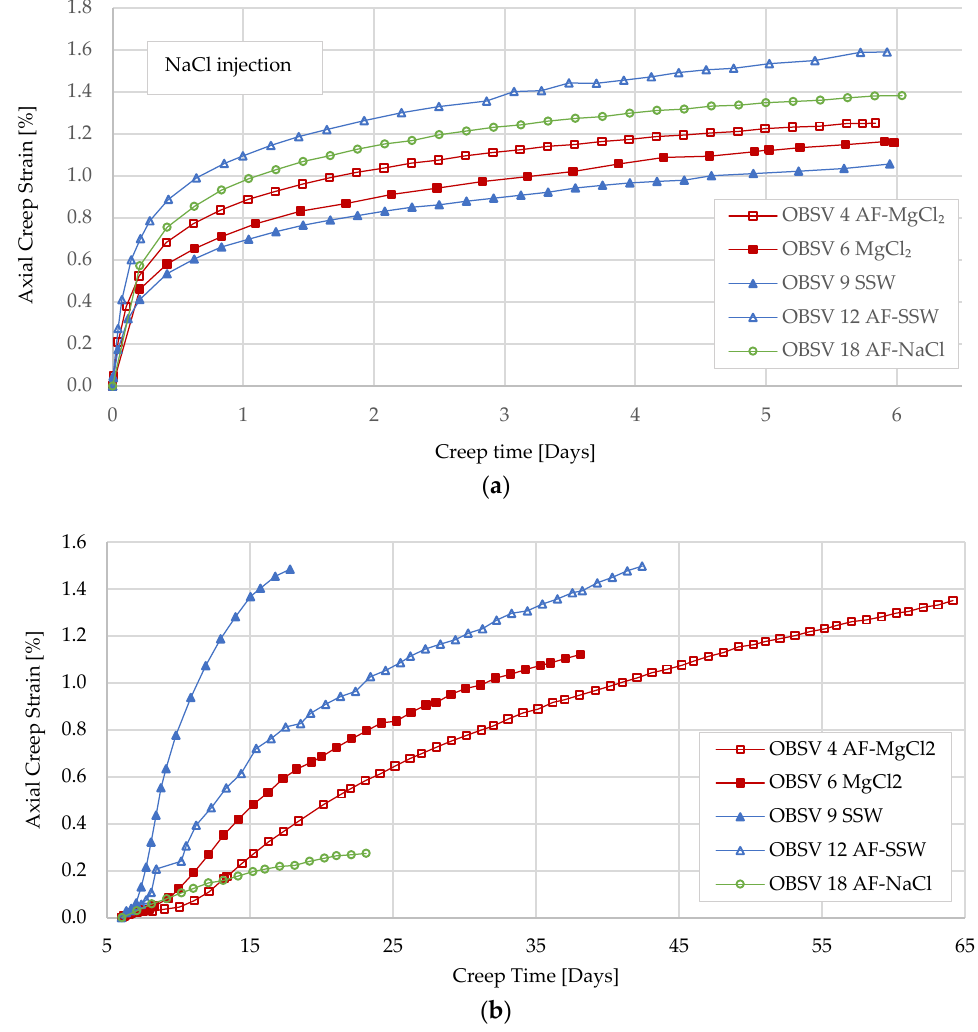
Figure 3. The graphs distribute the axial creep strain for Creep 1 and Creep 2: ( a ) Axial creep strain for five cores during Creep 1 with six days of NaCl injection for all samples. ( b ) Compaction behaviour during Creep 2 starting at day six, when the injected brine changed from NaCl to MgCl 2 and SSW, and OBSV 18 AF-NaCl continued with NaCl injection throughout the entire test period.